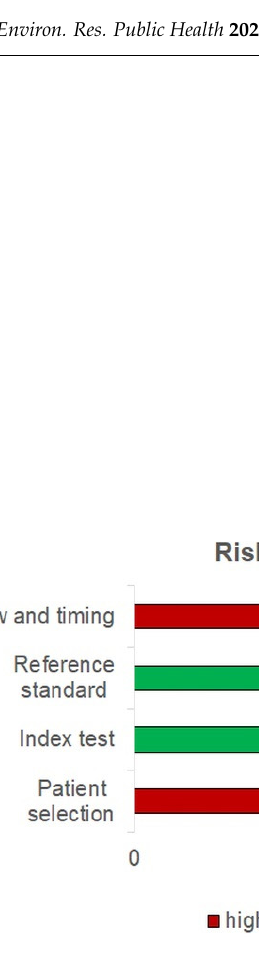
Figure 2. Qualitative assessment of 15 studies included in the meta-analysis using QADAS-2.